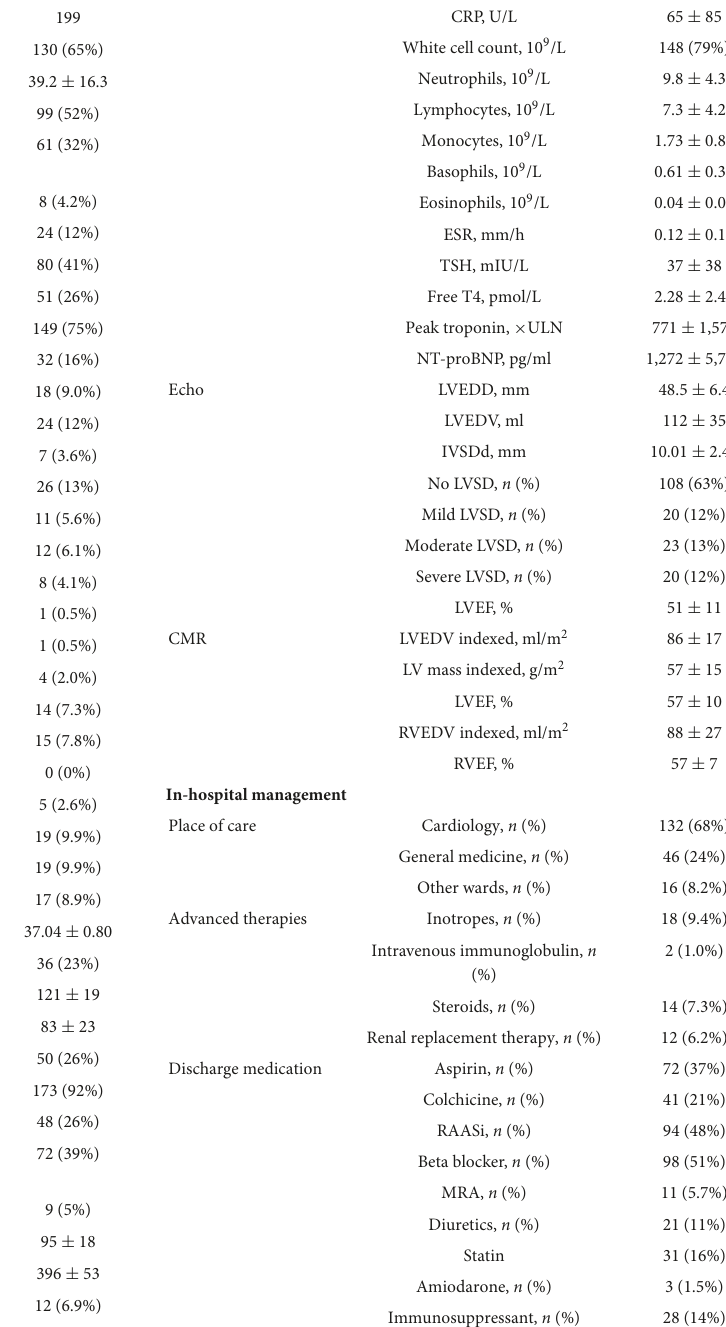
TABLE 1 Characteristics of study patients.